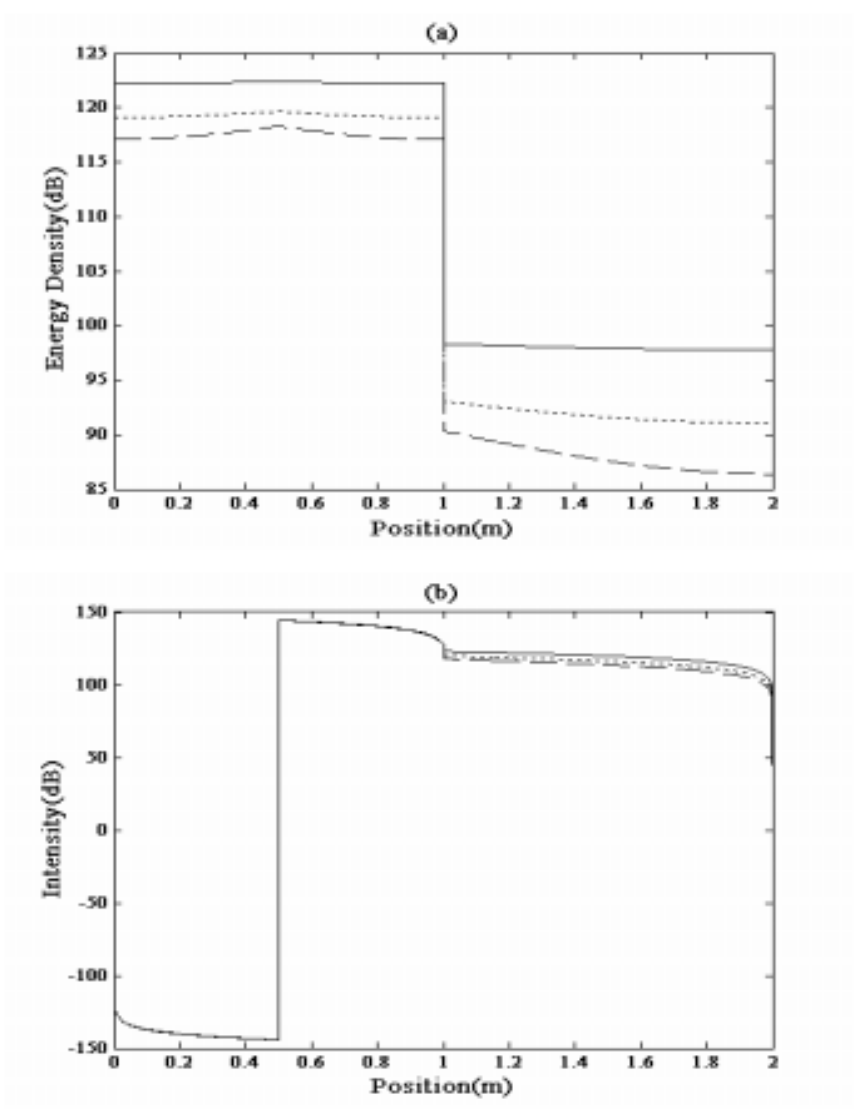
Fig. 6. Energy and intensity distributions of two-beam structure coupled with Φ = 90 ◦ when K x = K y = 10 9 N/m, K θ = 10 6 Nm/rad, C θ = 10 4 Nms/rad, C x = C y = 10 7 Ns/m and f = 1 kHz. (a) flexural wave energy, (b) flexural wave